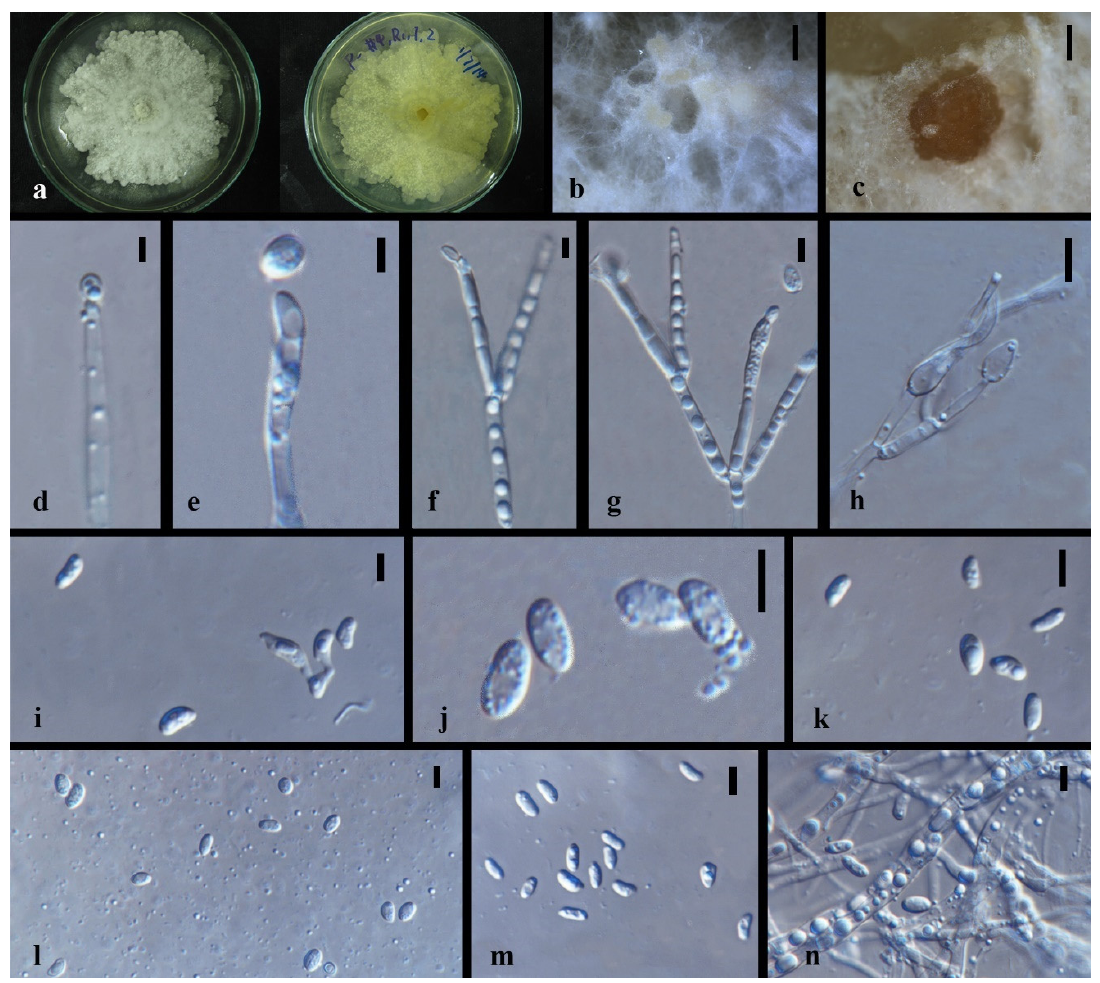
Figure 14. Xylaria sp. 1 ( a ) Colony on PDA (MFLUCC 14–0137) (left-front view, right-reverse view). ( b , c ) Conidiomata. ( d – h ) Conidiophores with conidia. ( i – m ) Conidia. n Mature mycelia. Notes: ( b – n ) on 4% OA. Scale bars: ( b , c ) = 500 μ m, ( d – n ) = 5 μ m. Index Fungorum number: IF 551823; Facesoffungi number: FoF 10273.